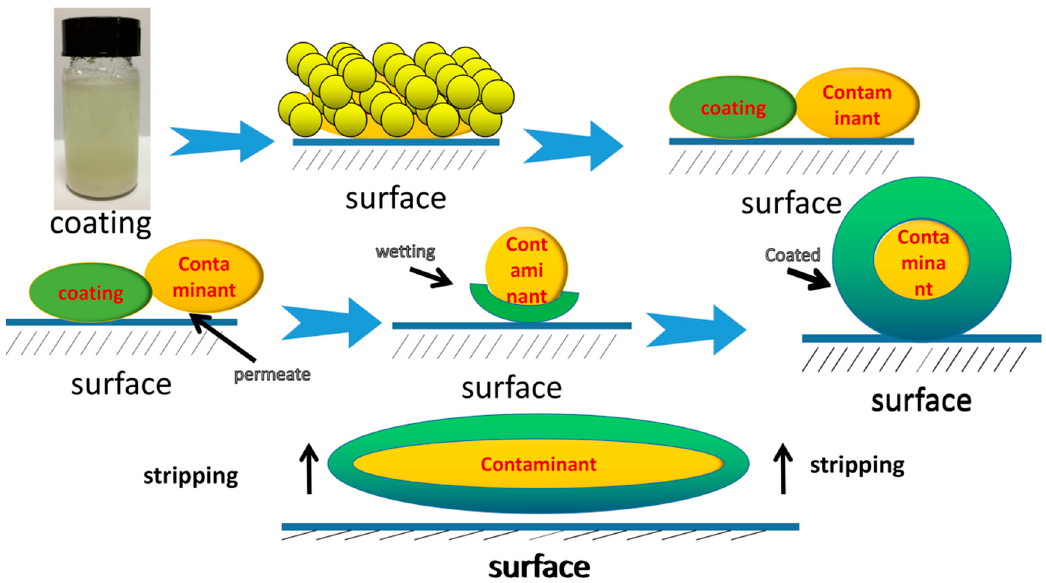
Figure 14. Diagram of strippable decontaminant.